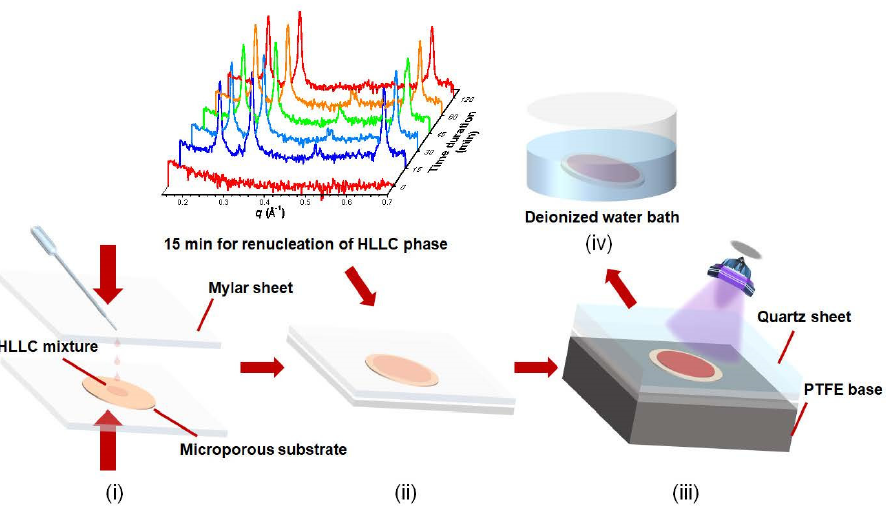
Figure 1. Schematic showing the hot-pressing process for the fabrication of TFC membranes. ( i ) ( iii ) UV curing and ( iv ) surfactant hot pressing, ( ii ) cooling, ( iii ) UV curing and ( iv ) surfactant removal.